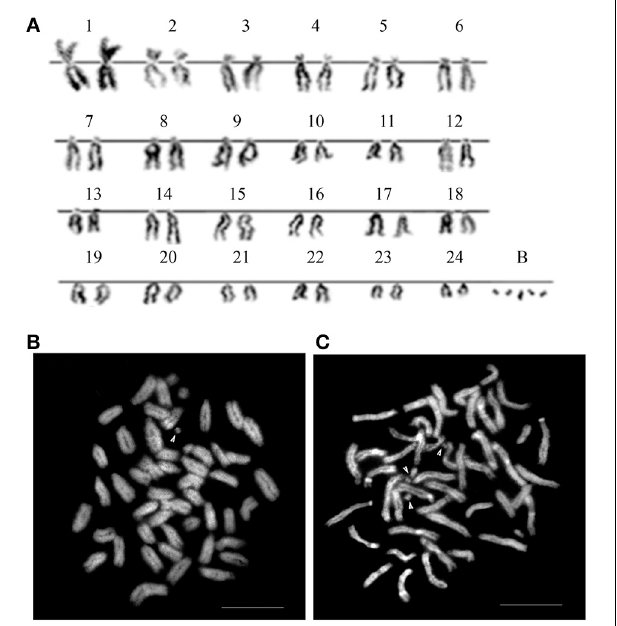
FIGURE 1 | The karyotype of Asian seabass contains 24 pairs of A-chromosomes and a variable number (2–10) of additional B-chromosomes. (A) The karyotype. Metaphase spreads stained with DAPI (B) and Chromomycin A3 (C) . Arrowheads in (B) indicate AT-rich B-chromosomes, whereas those in (C) label GC-rich